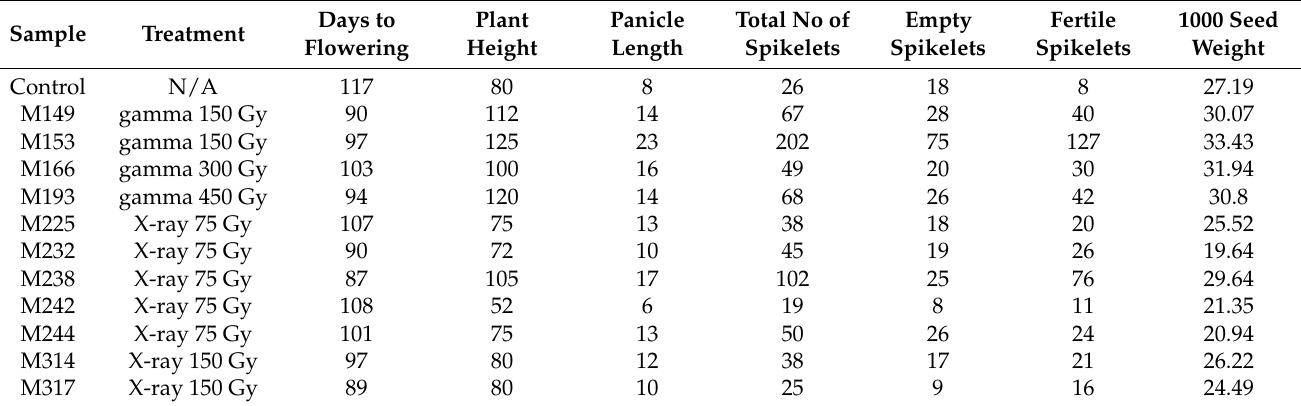
Table 2. Phenotypic characteristics of 11 mutant lines and the control selected for